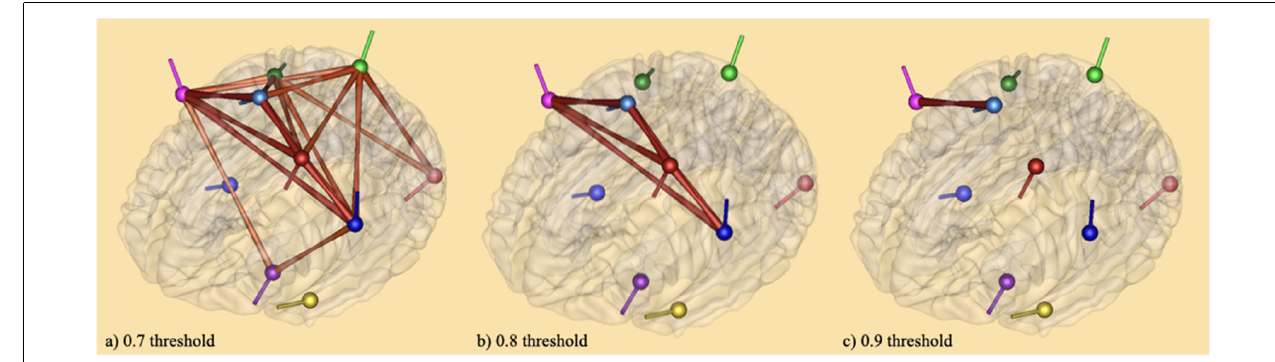
FIGURE 5 | Brain maps of coherence connectivity at (A) 0.7 threshold (B) 0.8 threshold and (C) 0.9 threshold in relation to tongue imagery. A coherence method followed by complex demodulation with time and frequency sampling 100 ms and 0.5 Hz respectively was applied in BESA Connectivity 1.0 software (BESA (cid:114) ). When the 0.7 threshold is considered, the connections across the vertices were significant for the baseline vs. tongue imagery ( p < 0.05) only. The vertices represent the significant brain areas reported by the source space analysis. The edges are loaded and colored according to the connectivity strength. They indicate significant higher (intense color) and lower (soft color) areas of synchronization both bilaterally and